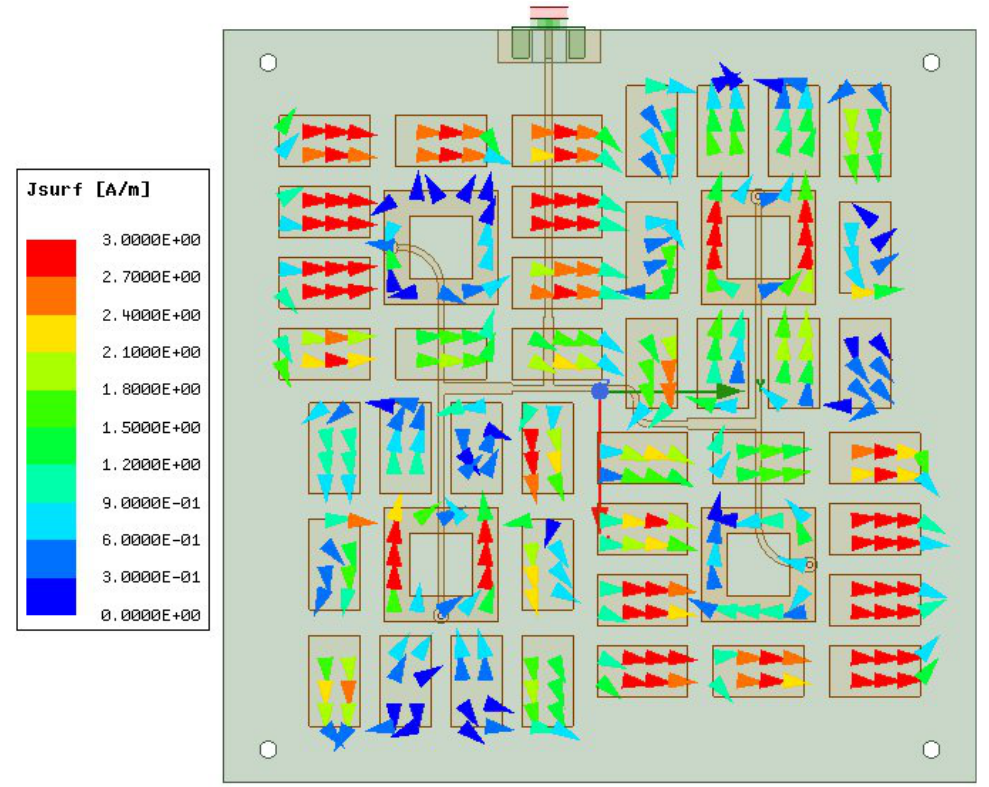
Figure 6. Surface current distribution at 4.5 GHz for the 2 × 2 metasurface